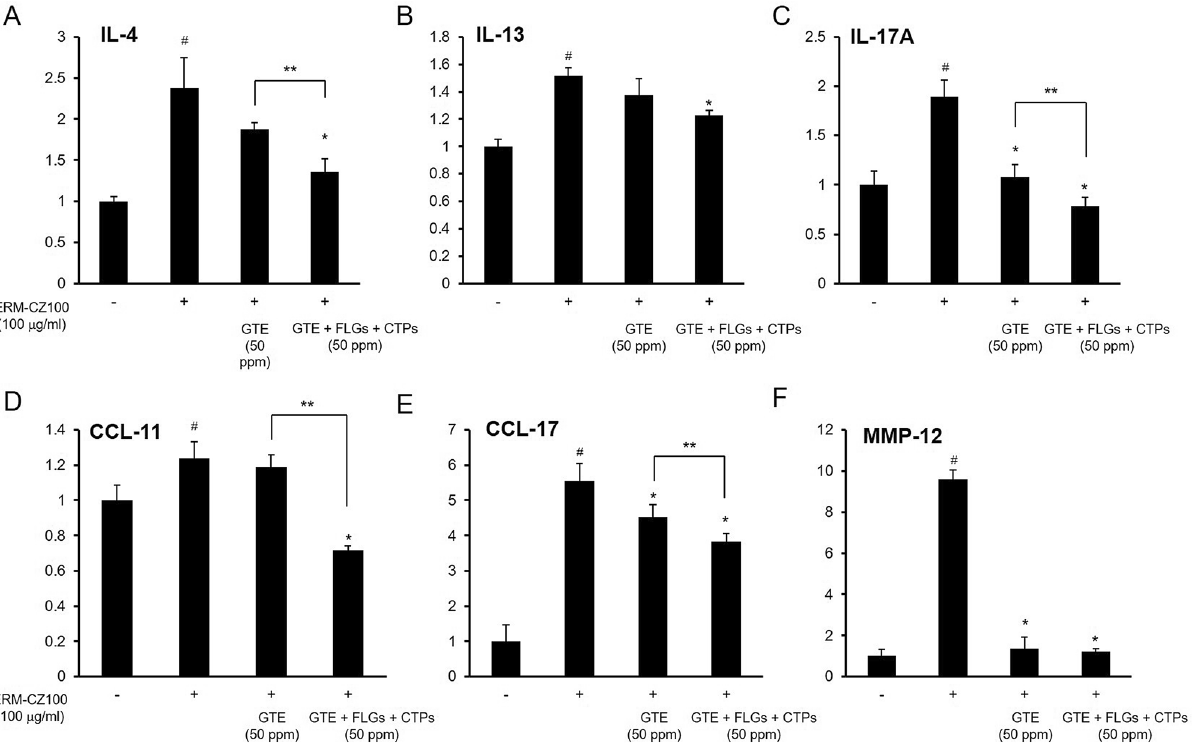
genes ( A ) IL-4, ( B ) IL-13, ( C ) IL-17A, ( D ) CCL-11, ( E ) CCL-17, and ( F ) MMP12 were measured in FDP- stimulated BEAS-2B cells. All results are either representative results or are expressed as the means ± SDs of the values obtained in three independent experiments (N = 3). * p < 0.05 compared to the FDP-treated group and ** p < 0.05 compared to combined treatment with GTE; # p < 0.001 compared to the vehicle control